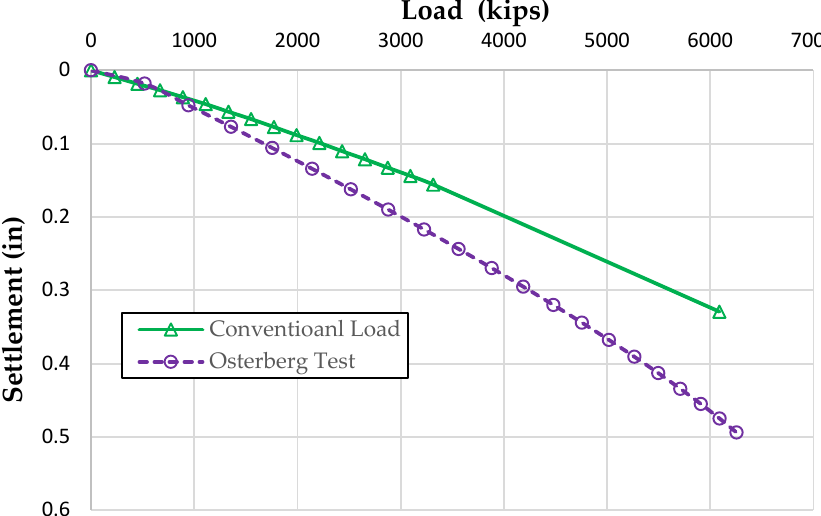
Figure 9. Constructed top-down curves based on the proposed back analysis, along with the conventional method according to the Osterberg assumptions, Case Study I.